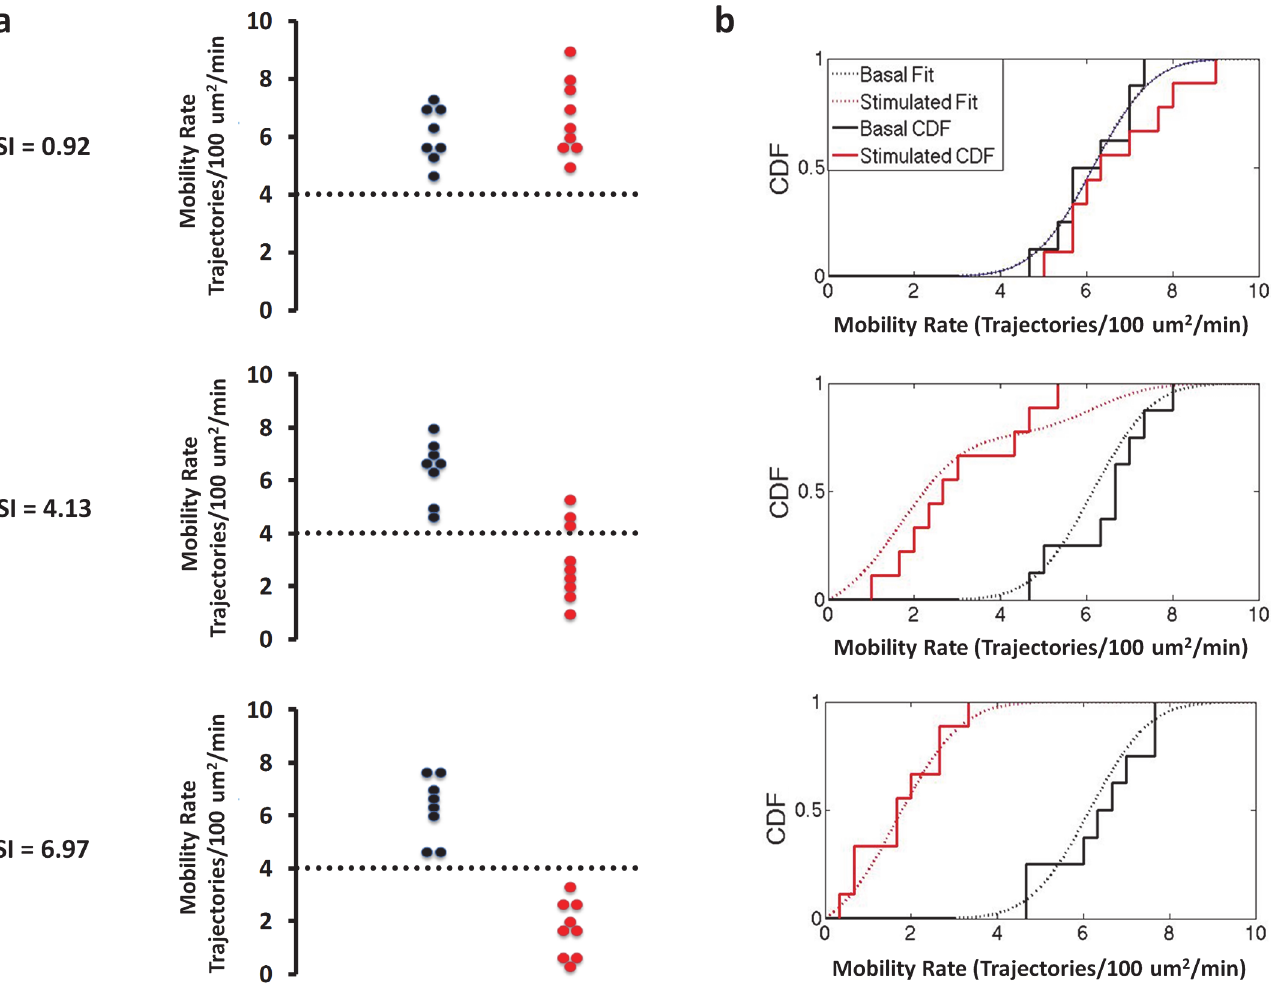
Fig 5. Representative “ Bee swarm ” plots (a) and empirical cumulative distribution functions (b) for basal (black) and insulin-treated (red) GSV mobility rates measured in adipose cells isolated from subjects with varying degrees of insulin sensitivity reveals two populations at the individual subject level. Dashed lines represent cluster boundaries calculated using the K-means clustering function. At low SI both the basal and insulin stimulated distributions are fit by a single, basal function. With increasing SI, increasing number of cells shift from the basal into the insulin-stimulated state characterized by low GSV mobility (less than 4 Trajectories/100 μ m 2